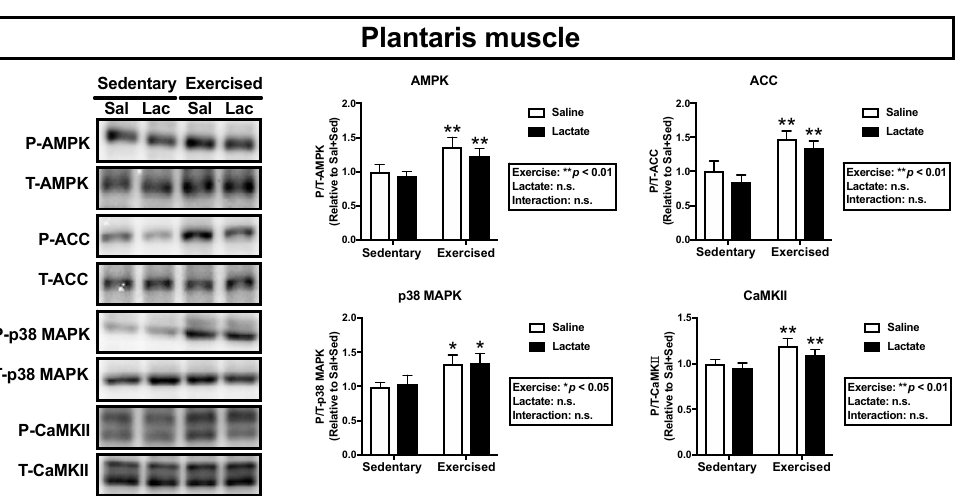
Figure 4. Phosphorylation of intramuscular signaling kinases in the plantaris 60 min after lactate ingestion (i.e., immediately after the exercise). Data are presented as means ± SEM ( n = 8). * p < 0.05, ** p < 0.01: main effect of endurance exercise.